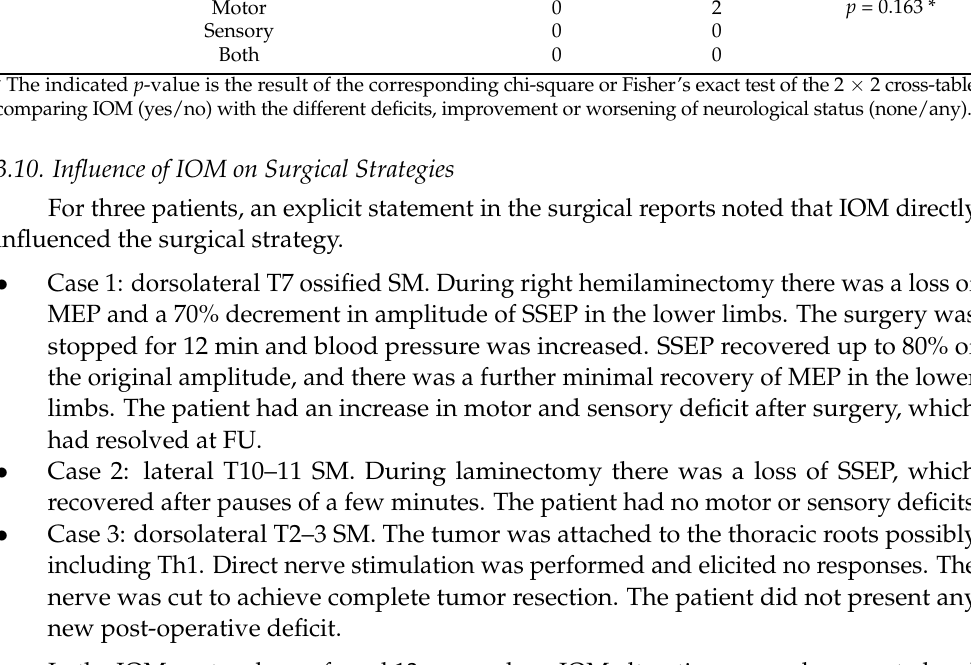
Table 5. Cont. IOM No-IOM Neurological improvement at follow-up *None 23 13 p = 0.463 Sensory 12 7 Motor 7 7 Both 9 8 Neurological worsening directly after surgery *None 50 32 p = 0.300 Sensory 0 0 Motor 0 1 Both 1 2 Neurological worsening at follow-up *None 51 33 p = 0.163 Motor 0 2 Sensory 0 0 Both 0